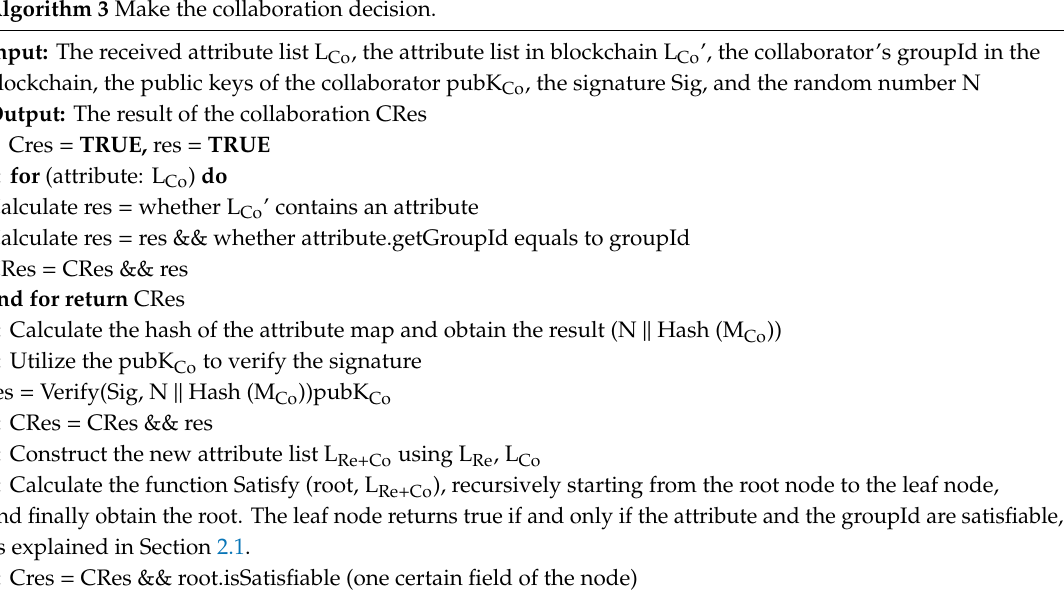
Figure 6. Verifiable and controlled collaboration mechanism. Algorithm 3 Make the collaboration